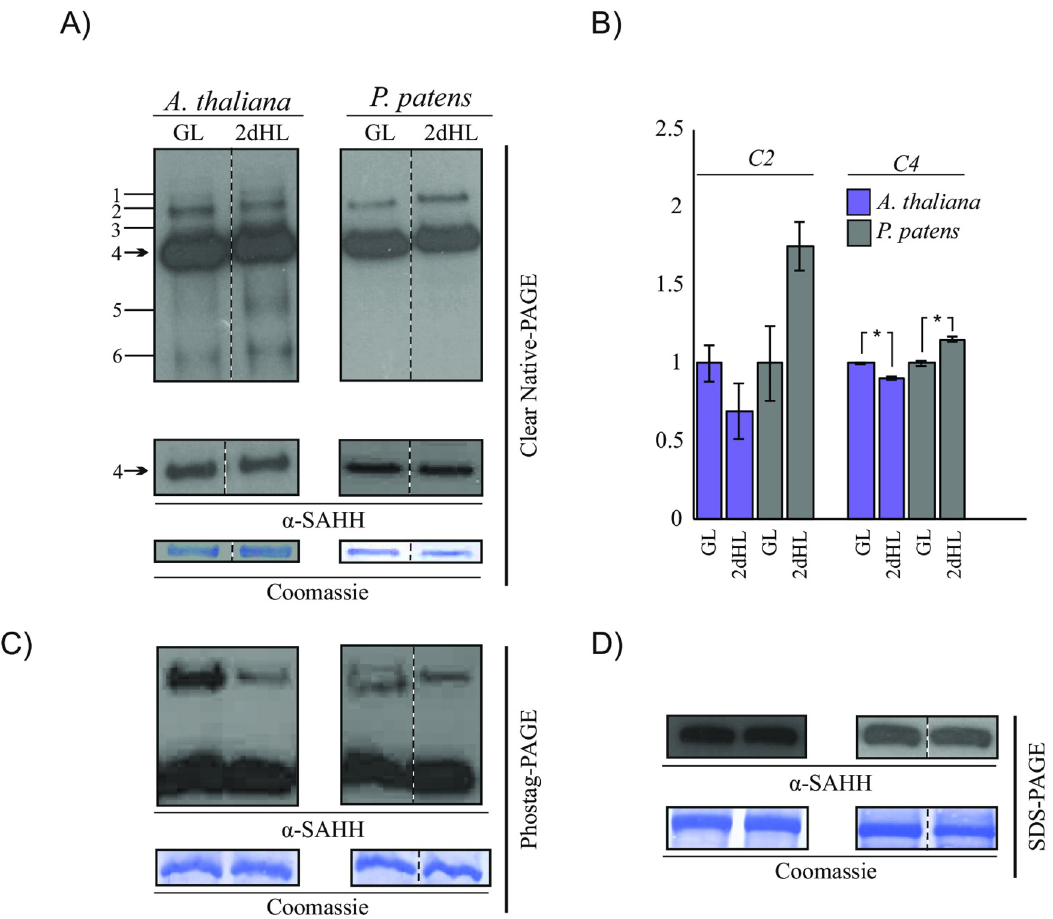
Fig 5. Light-stress-induced adjustments in SAHH. A . thaliana was grown under 130 μ mol photons m -2 s -1 for 16 days and thereafter shifted 800 μ mol photons m -2 s -1 for 2 days. P . patens as a shade-adapted moss species was grown under 45 μ mol photons m -2 sec -1 for 13 days and thereafter illuminated under 500 μ mol photons m -2 s -1 for two days. SAHH was separated by gel-based systems and immunodetected by using an anti-SAHH antibody. Coomassie-stained membranes are shown as loading controls for each experiment. A) Oligomeric protein complexes as detected by anti-SAHH antibody and clear native (CN)-PAGE in A . thaliana and P . patens in growth light (GL) and after 2-day illumination under high light (2dHL). Six oligomeric protein complexes detected by the anti-SAHH antibody in A . thaliana are indicated by numbers. The lower panel depicts an immunoblot with a shorter exposure time for visualization and quantification of the abundant SAHH complex 4. B) Quantification of protein complexes recognized by α -SAHH antibody in Arabidopsis thaliana and Physcomitrella patens in growth light and after two-day exposure to high light. C2 and C4 refer to Arabidopsis SAHH complexes 2 and 4, and complexes with similar apparent molecular weights in P . patens . Relative values are presented. The t-test p-values obtained were 0.053 for A . thaliana C2, 0,083 for P . patens complex that co- migrated with A . thaliana C2, 0.0008 for A . thaliana C4 and 0.001 for P . patens complex that co-migrated with A . thaliana C4. The asterisks indicate statistically significant difference at P < 0.005; n = 3. C) SAHH protein phosphorylation as detected by anti-SAHH antibody and Phostag-PAGE in A . thaliana and P . patens in growth light (GL) and after 2-day illumination under high light (2dHL). D) SAHH protein abundance as detected by anti-SAHH antibody and SDS-PAGE in A . thaliana and P . patens in growth light (GL) and after 2-day illumination under high light